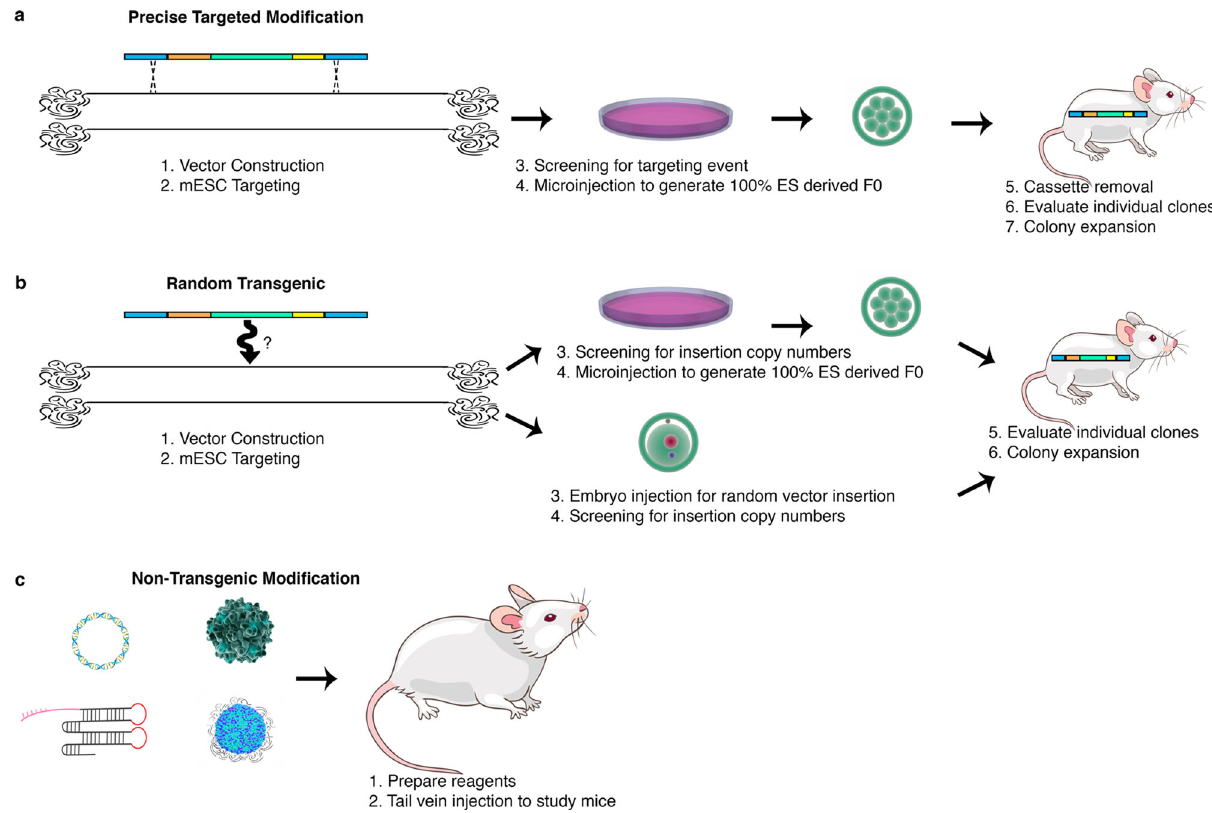
Fig. 7 Overview of methods used to generate in vivo overexpression models . Timeline of overexpression allele generation by a targeted mESC, b random transgenic in mESC or embryos, and c tissue-speci fi c, non-transgenic, delivery of